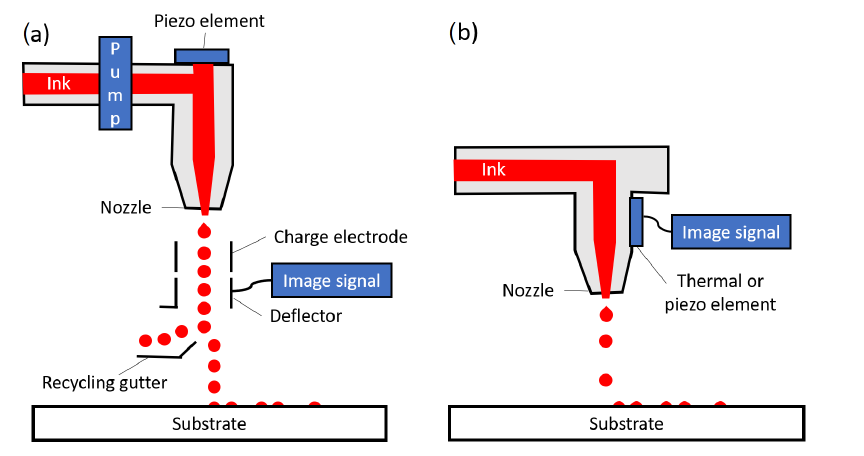
Figure 17. Schematics of ( a ) CS and ( b ) DOD inkjet